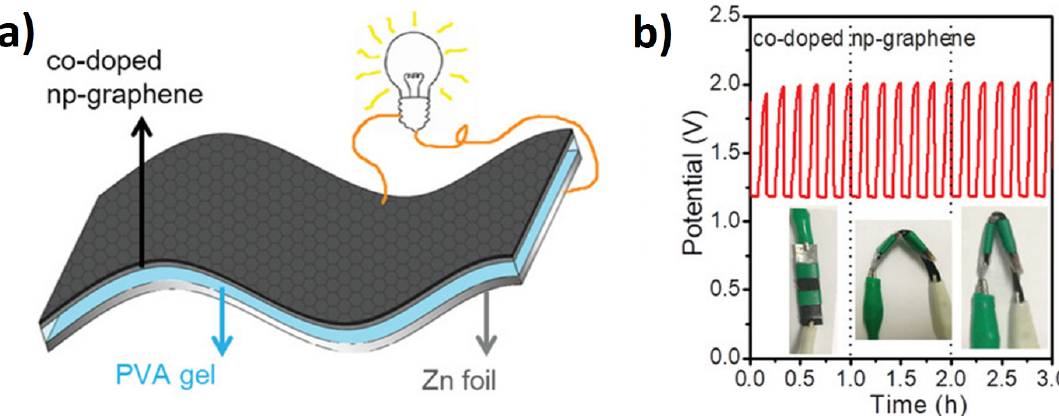
Figure 15. ( a ) Schematic diagram of the co-doped np-graphene-based all-solid-state Zn-air battery; ( b ) Discharge/charge curves under different bending states. Reprinted with permission from ref. [77]. Copyright 2019 WILEY-VCH Verlag GmbH & Co.